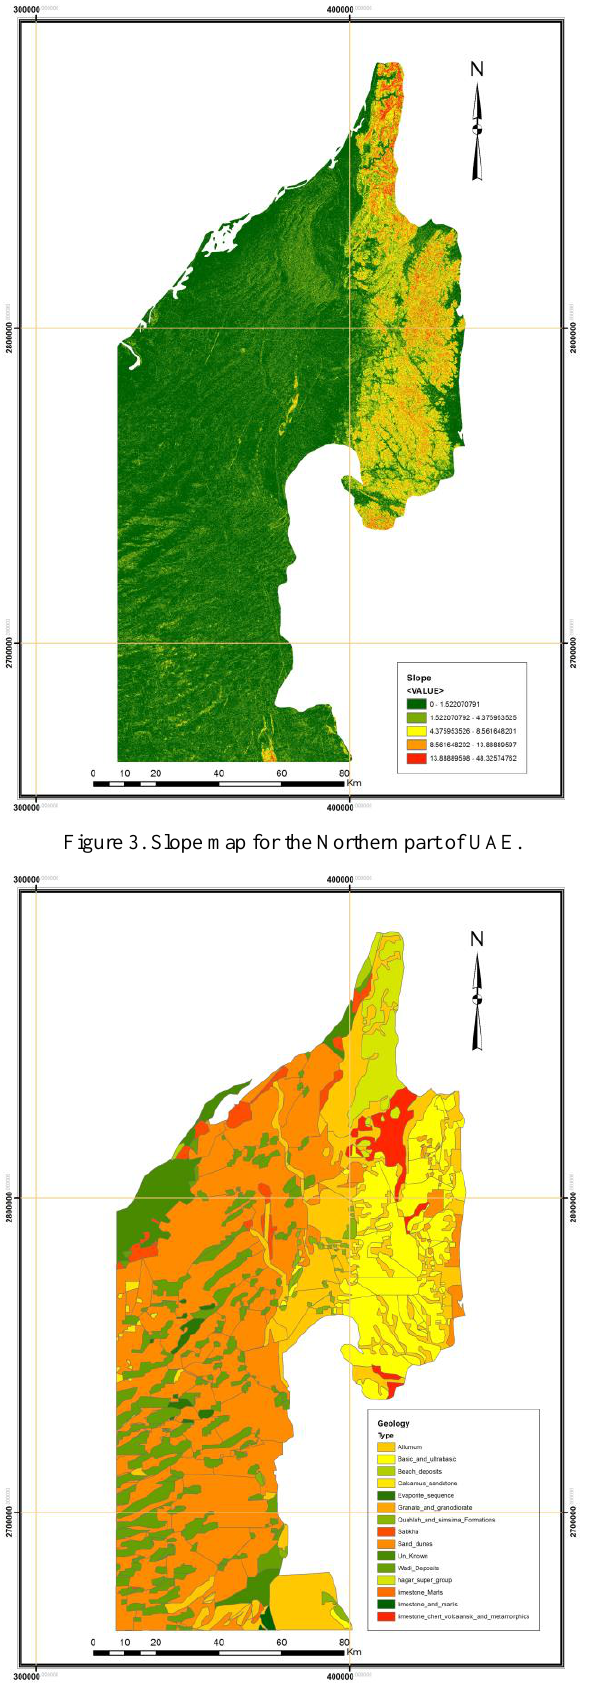
Figure 4. Geology map for the Northern part of UAE.